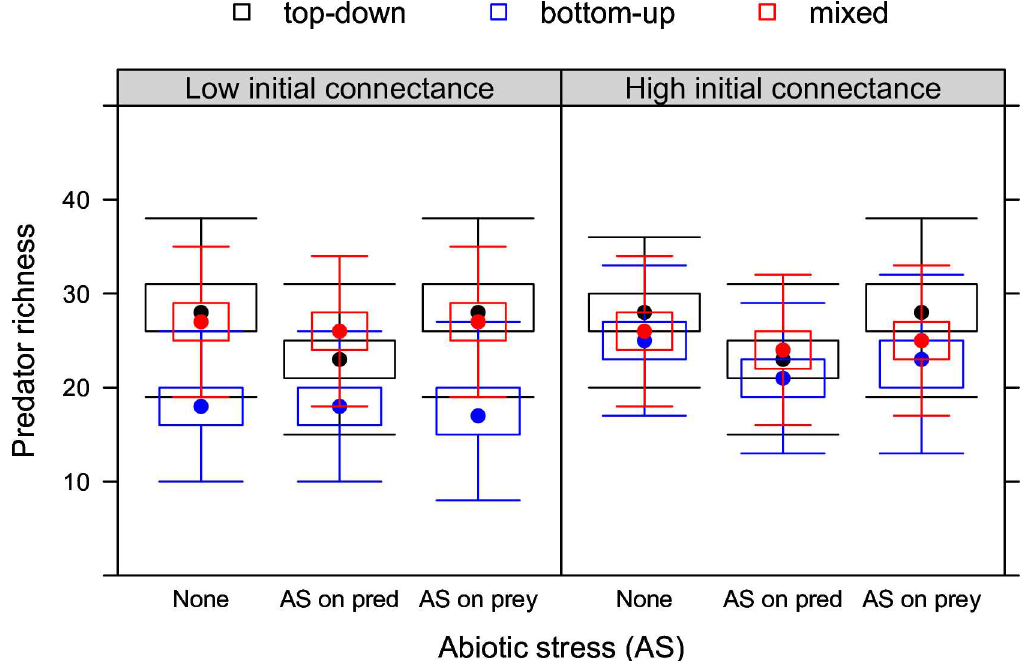
Fig 2. Predator richness under stress. Biotic stress (top-down, bottom-upor mixed control) and abioticstress (none, AS on prey, AS on predators) at low and high initial connectance.